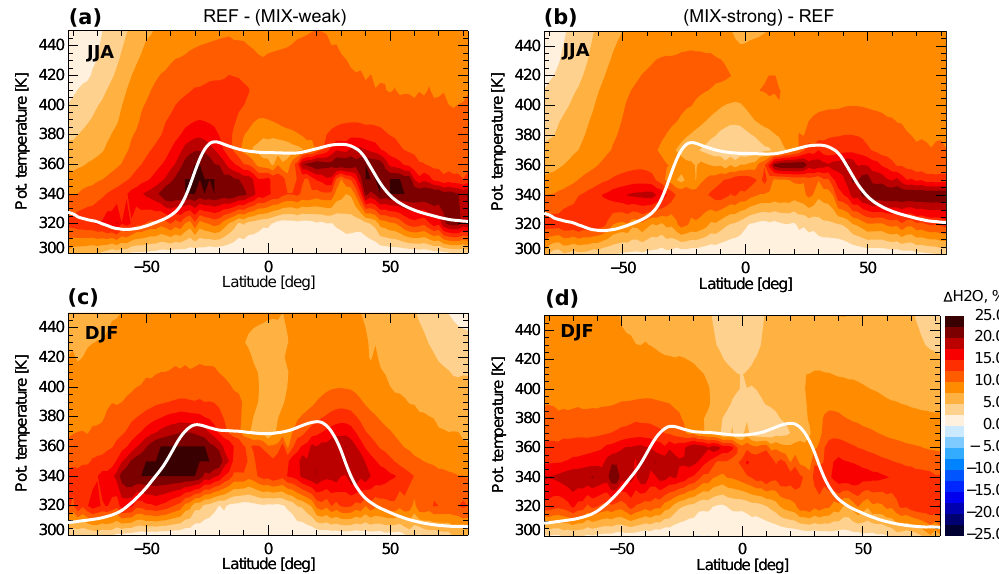
Figure 15. Relative differences of zonal mean water vapour for summer (a, b) and winter (c, d) seasons for 2011 between the reference and weak mixing and between the strong mixing and reference case for the LS region. Tropopause is represented by a white solid line, which is calculated from ERA-Interim reanalysis data.